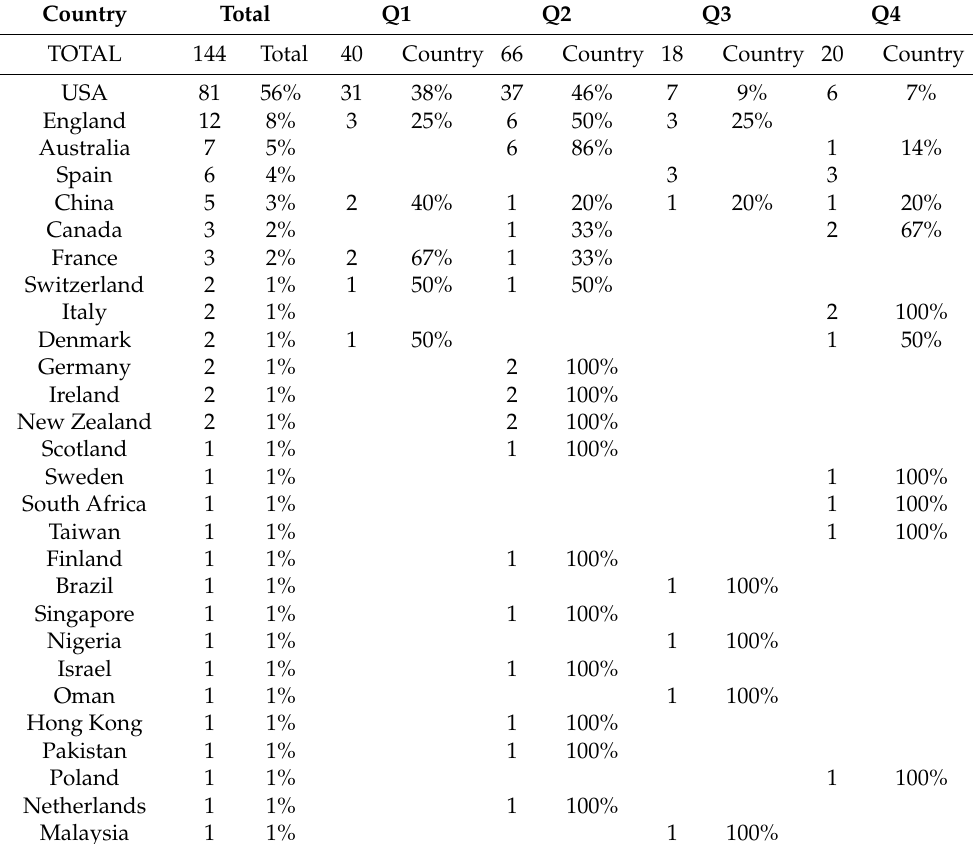
Table 6. The evolution of the relevance of the subjects dealt with in the literature on gender and